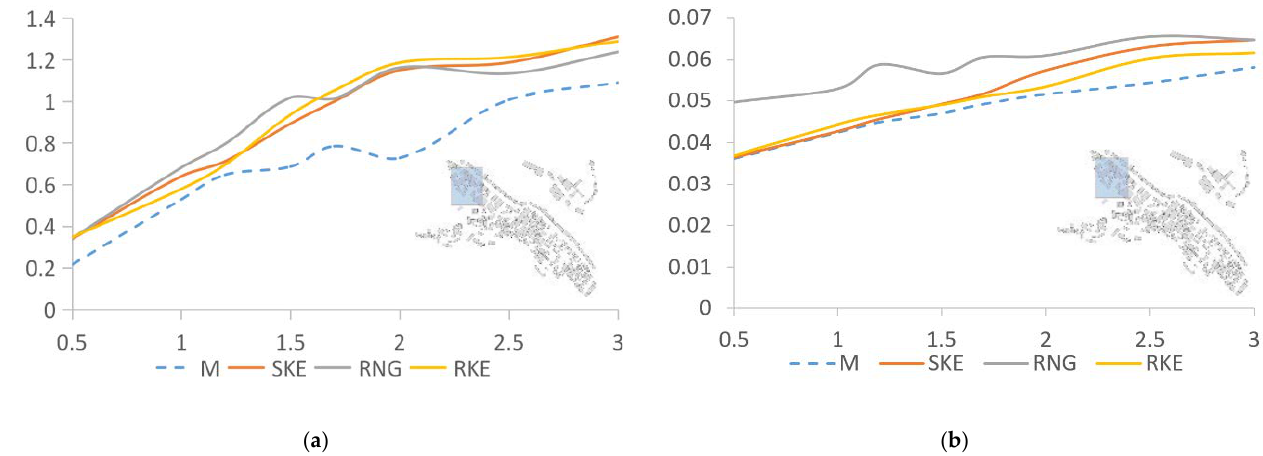
Figure 6. Analysis of measured and simulated data produced by SKE, RNG, and RKE in an area with a building density of 37.14%. ( a ) Wind speed comparison between SKE, RNG, RKE, and measured data; ( b ) Comparison of turbulence intensity between SKE, RNG, RKE, and measured data.